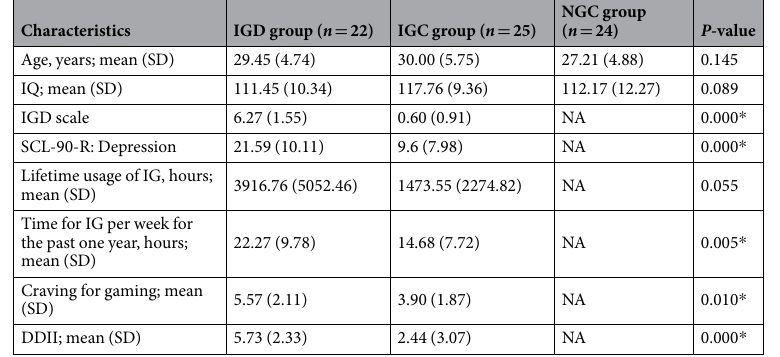
Table 1. Sample characteristics. Abbreviations. DDII, Dickman’s Dysfunctional Impulsivity Inventory; IG, Internet gaming; IGC, Internet gaming control; IGD, Internet gaming disorder; IQ, intelligence quotient; NGC, non-gaming control; SCL-90-R, Symptom Checklist-90-Revised. * Significant at P <